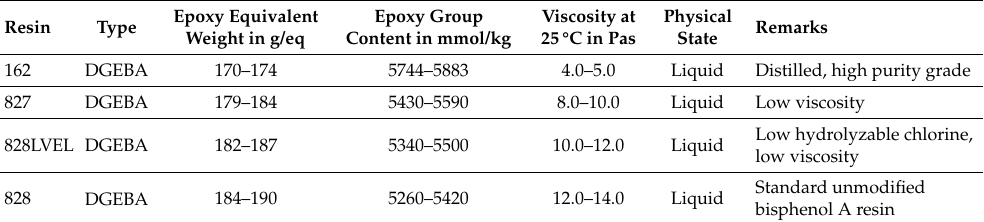
Table 1. Properties of used epoxy resins.